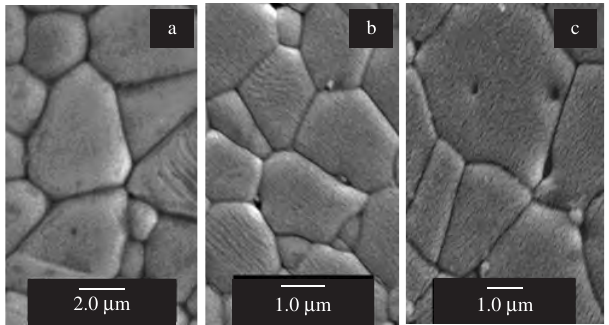
Table 1. Relative density ( ρ / ρ t ), grain size values ( d ), mean values of the nonlinear coeffcient ( α ), breakdown electric field ( E ( I ) obtained for the varistor ceramic systems. l